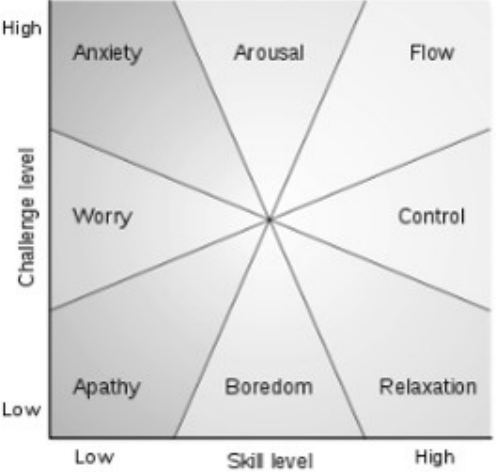
Figure 1. Mental states in terms of challenge level and skill level, according to Csikszentmihalyi´s fow model (Csikszentmihalyi, 1998; Delle Fave, Massimini & Bassi,